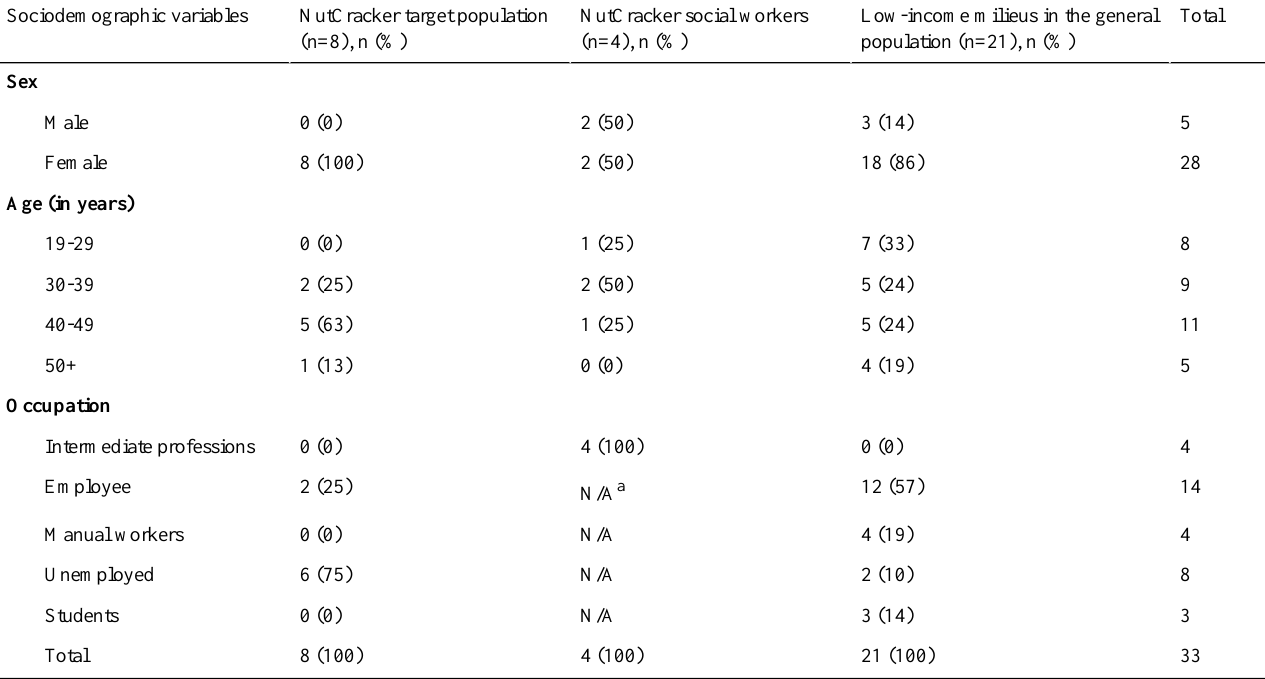
Table 1. Sociodemographic characteristics of the participants.